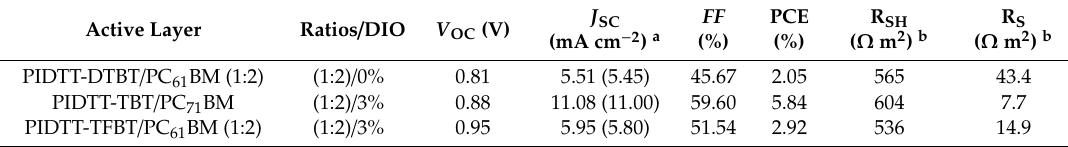
Figure 7. The optimal J - V curves ( a ) and the EQE spectra ( b ) of the polymer solar cells (PSCs) based on the resultant polymers. Table 3. The optimized PV parameters of PSCs based on the studied copolymers.